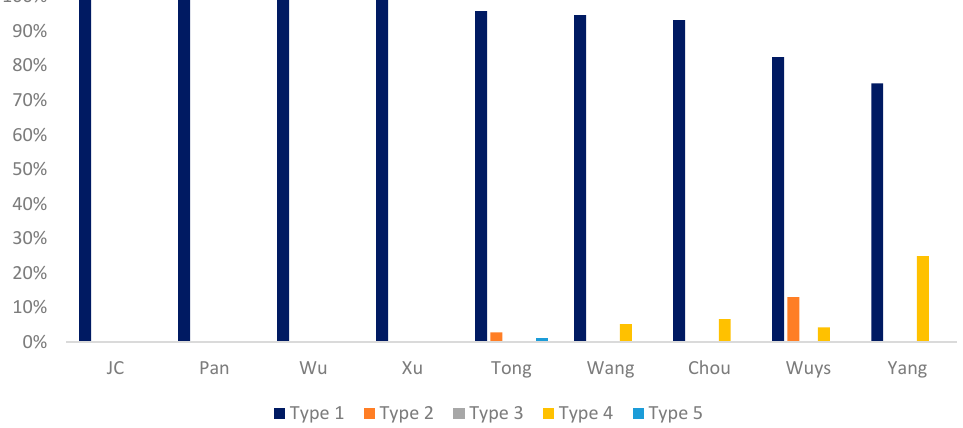
Figure 1. Proportions of di ff erent types of semantic categories of 打 dˇa by individual child. Type 1: Physical action focusing on hand contact; Type 2: hand action (mostly with instrument); Type 3: physical action with physical contact unspecified; Type 4: metaphorical uses (hand action traceable); Type 5: metaphorical uses (hand action untraceable).